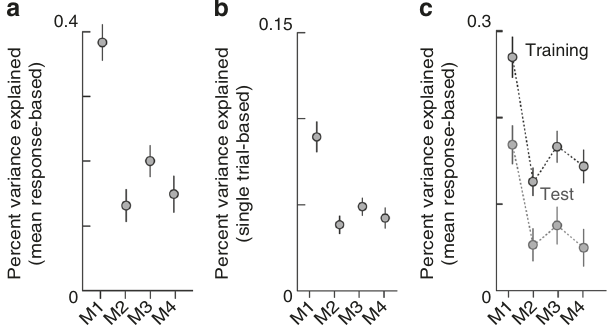
Fig. 5 Comparisons of the model performances for relative value coding. a Plots of the percent variance explained by the four normalization model for the mean response-based data estimated in 20 lottery pairs. b Same as a , but for the single trial-based data. c Plots of the percent variance explained by the models for the mean response-based data when cross-validation was performed. Percent variance explained for training data and test data are as a null model and an arti fi cial model (Fig. 4c, n = 81, one- sample t -test, df = 80; M1 – M5, P < 0.001, t = − 8.71; M1 – M6, P < 0.001, t = − 7.76; M1 – M7, P < 0.001, t = − 10.2; M1 – M8, P = 0.009, t = − 2.68; M1 – M9, P < 0.001, t = − 7.09; M1 – M10, P < 0.001, t = − 6.96). In summary, of the models tested, relative value coding in the activity of mOFC neurons was most consistent with a divisive normalization computation.